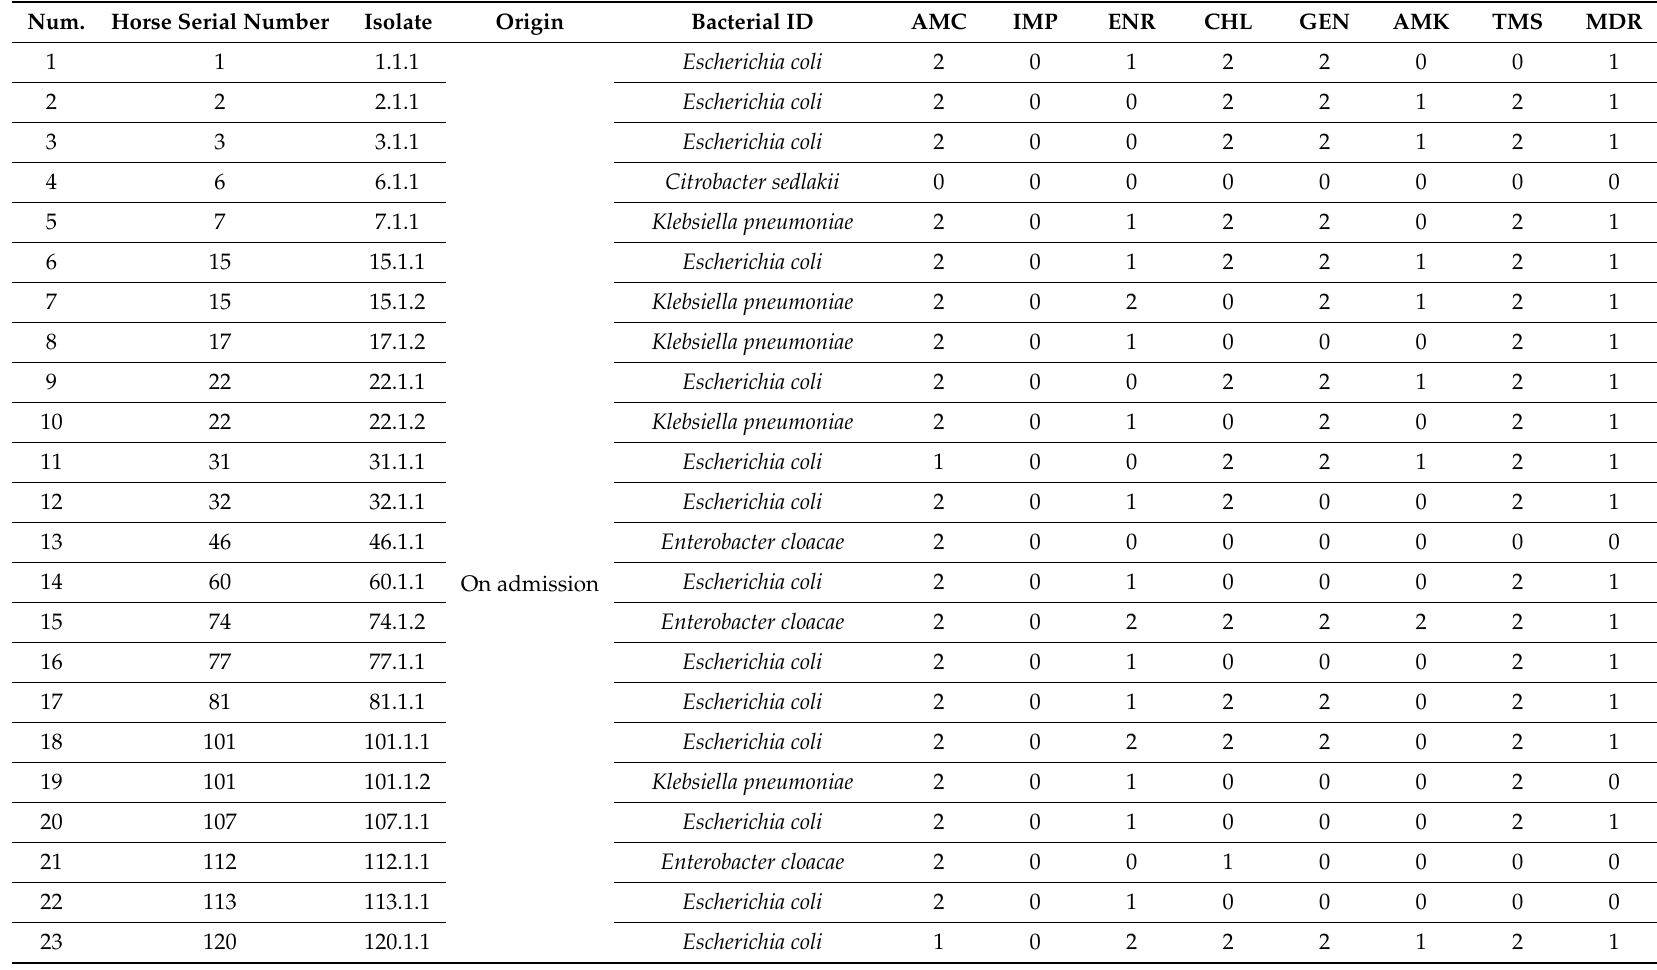
Table A1. Antimicrobial susceptibility profiles of individual